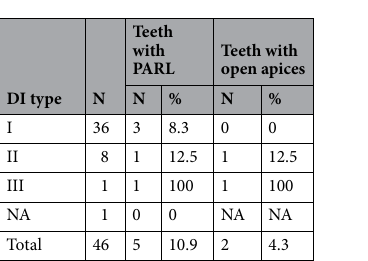
Figure 1. Representative CBCT images of the three DI types (yellow arrows). ( a – c ) Maxillary lateral incisor with DI type I. ( d – f ) Mesiodens with DI Type II. ( g – i ) Maxillary lateral incisor with DI type III. ( a , d , g ) Sagittal sections. ( b , e , h ) Coronal sections. ( c , f , i ) Axial sections.